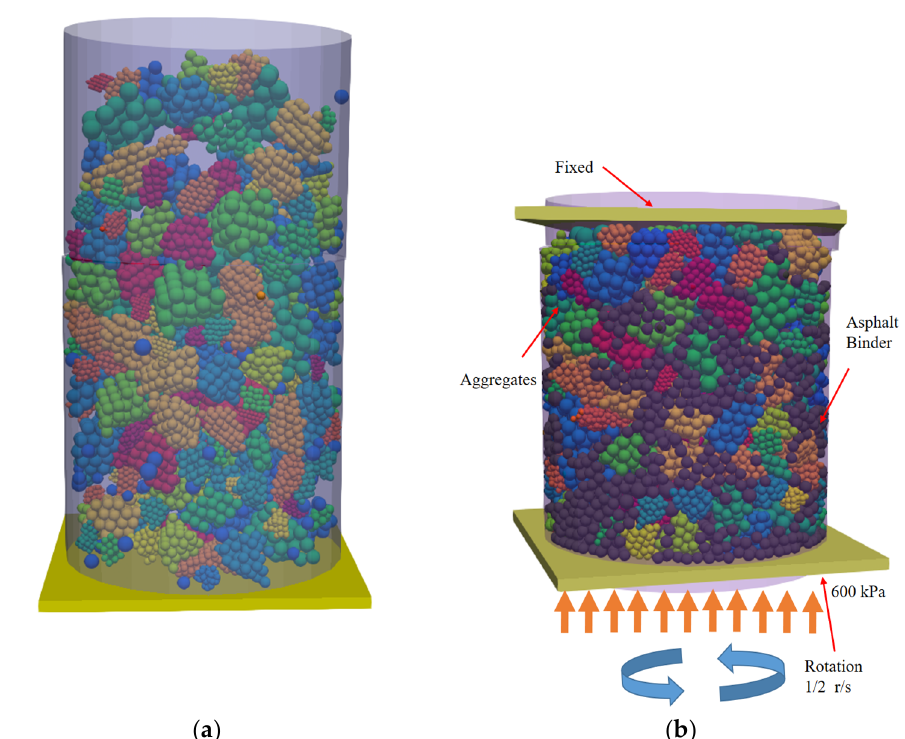
Figure 7. DEM simulation process: ( a ) stacked states by gravity; ( b ) compacted states after gyratory compaction.